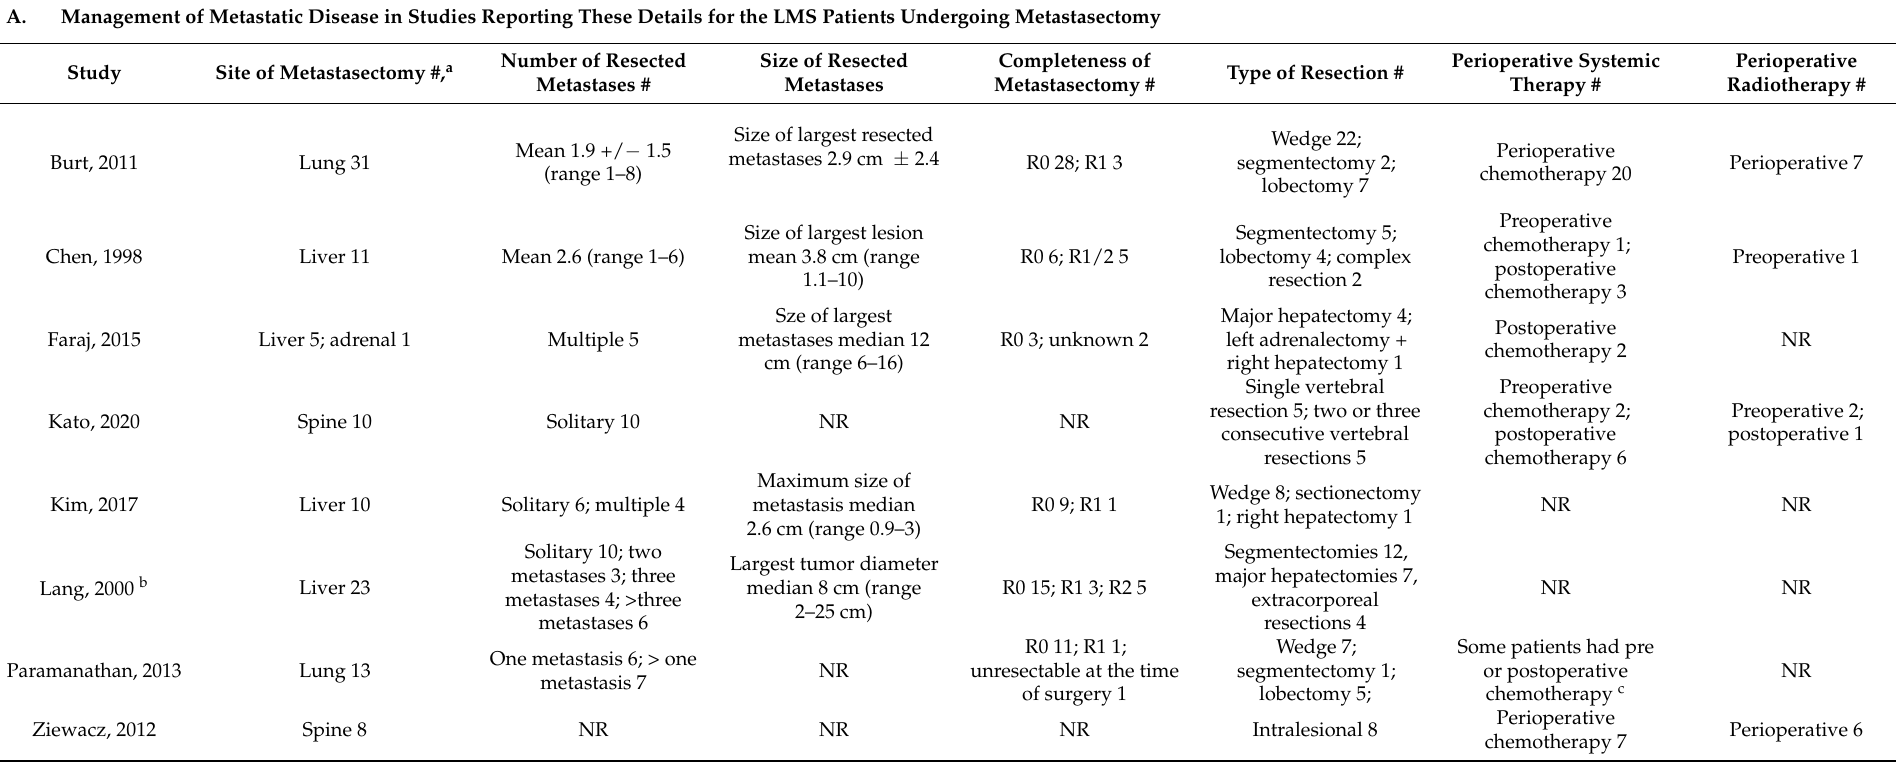
Table 3. Management of metastatic disease in studies reporting (A) and not reporting (B) these details for the LMS patients undergoing metastasectomy.